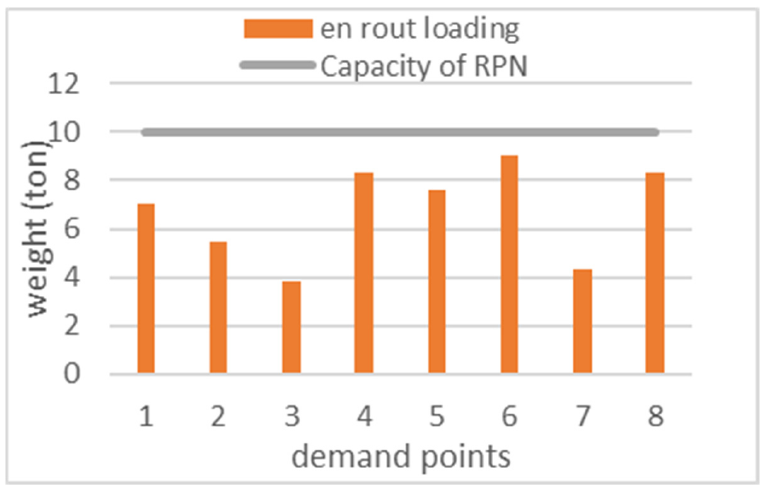
Figure 7. Compliance check for initial loading constraint.